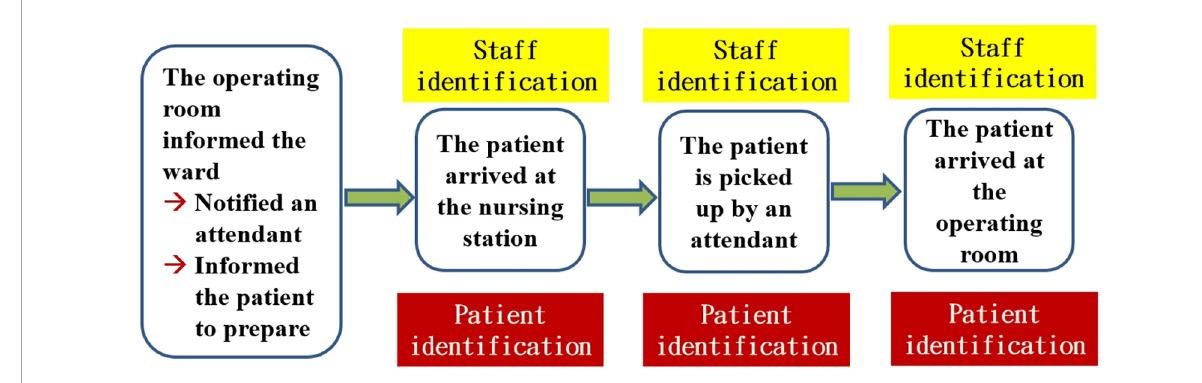
FIGURE9 The future process based on computer information-assisted patient and staff identification.